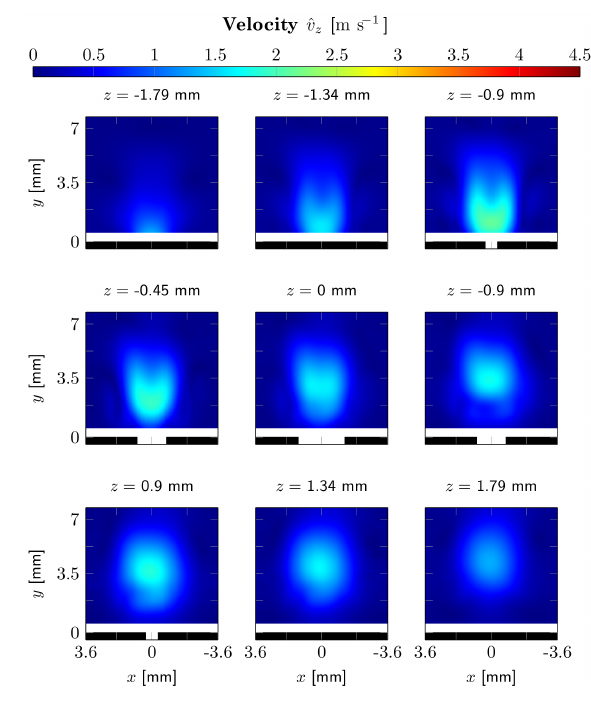
Figure 13. Amplitude of the sound-excited flow velocity oscilla- tions in z direction.